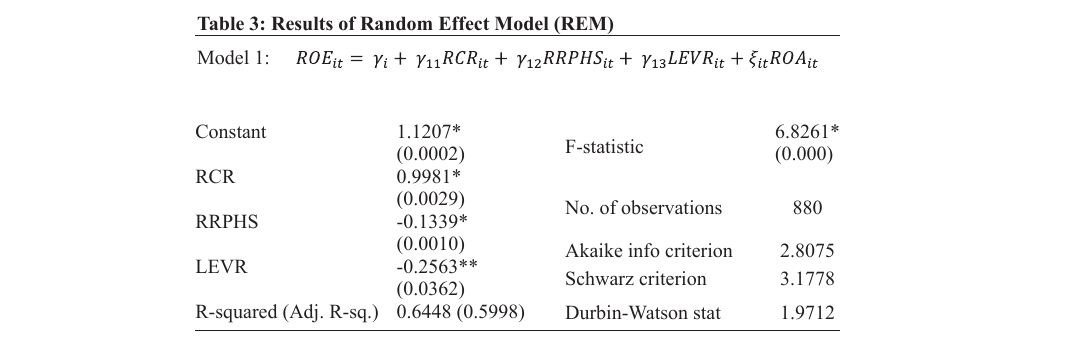
Table 3: Results of Random Effect Model